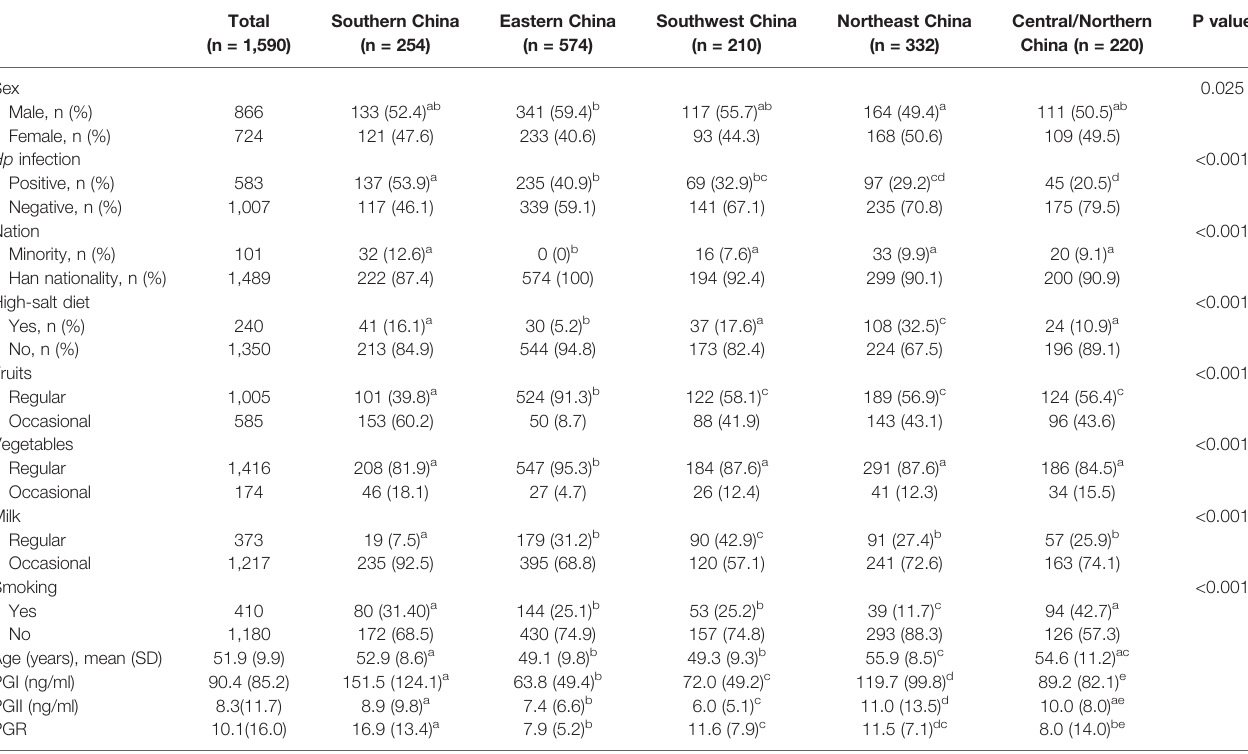
TABLE 3 | Differences of PG baseline levels among the different regions in the NAG